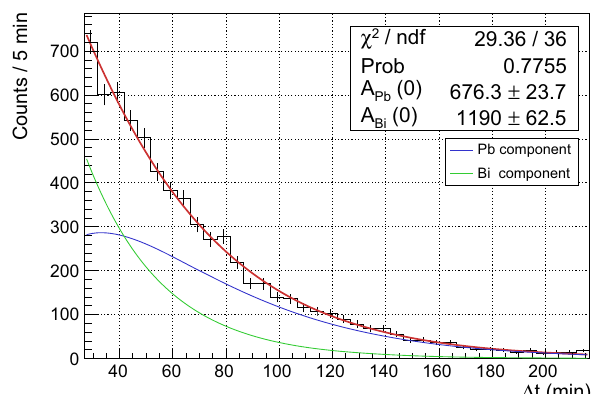
Fig. 3 Experimental spectrum (black) and selection of 223 Ra parent events (red) followed by 219 Rn and 215 Po daughter events (blue and green,